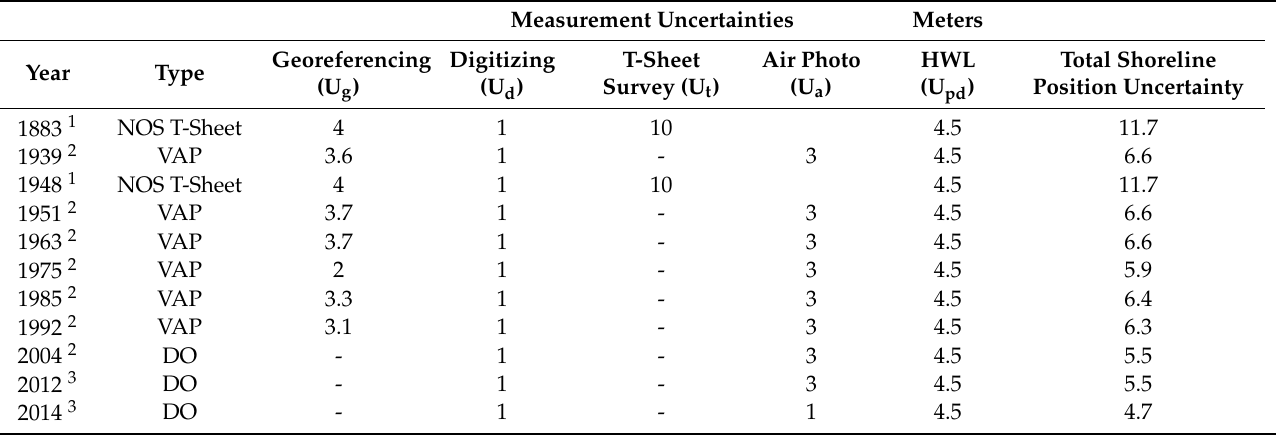
Table 3. Reported measurement and total positional uncertainties reported for the shorelines used in this analysis. Sources notes by the superscript next to the date. 1 Hapke et al. [25]. 2 Boothroyd and Hehre [24]. 3 Boothroyd et al.